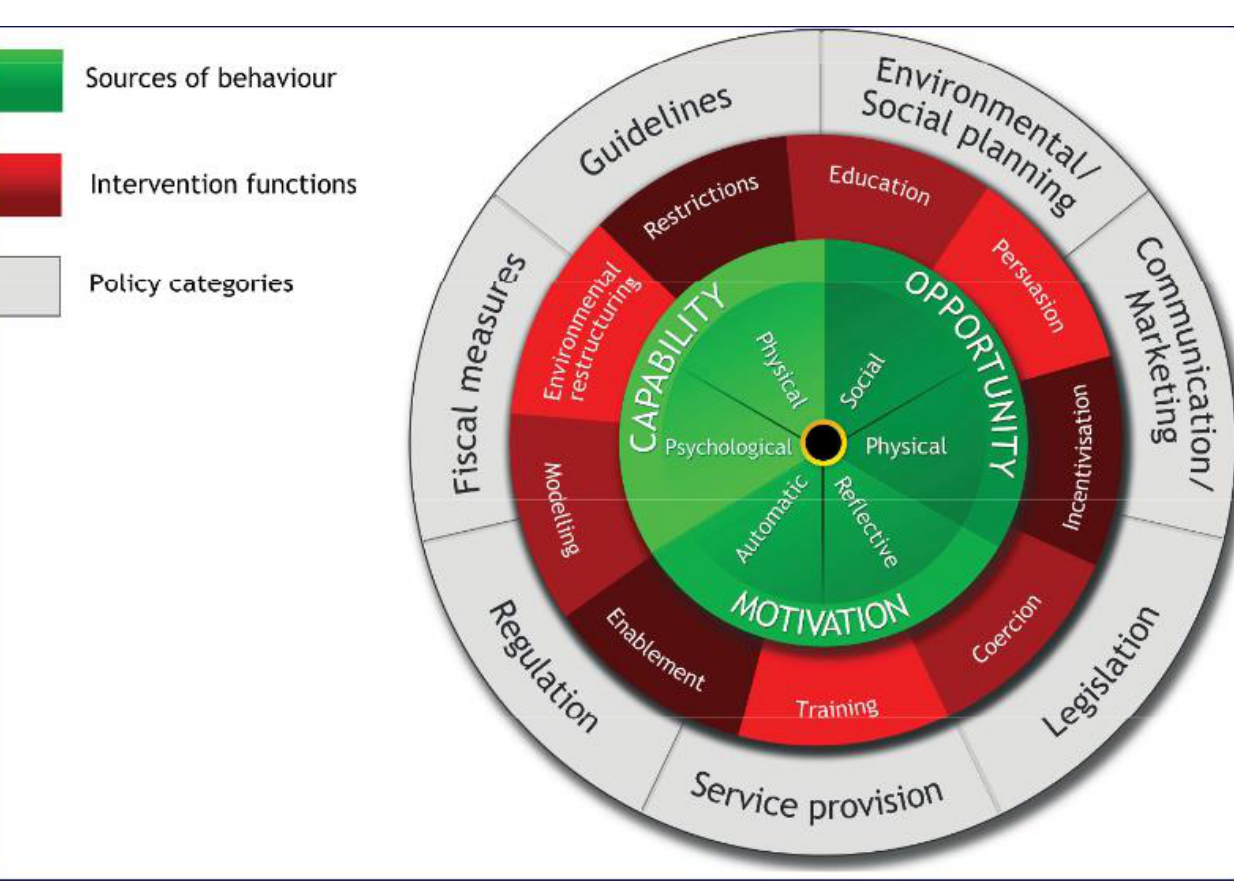
Figure A1. Behaviour change wheel.